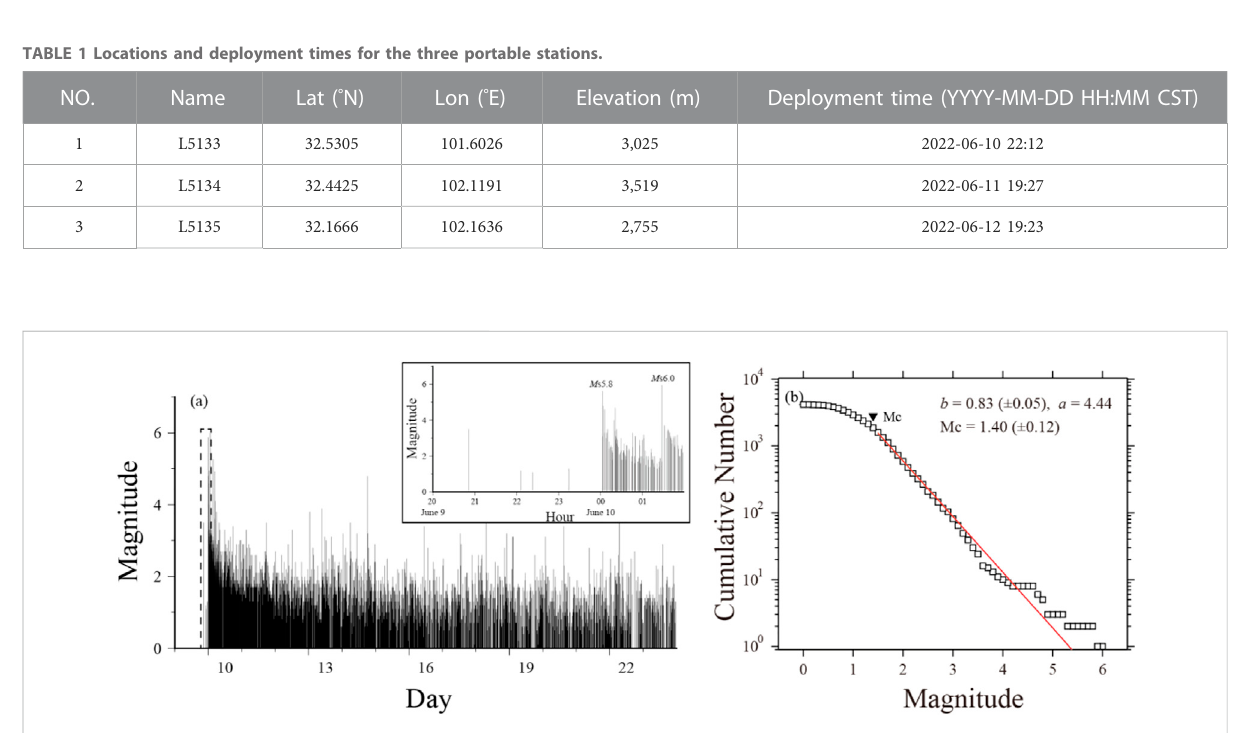
FIGURE 2 (A) M – t diagram of the Maerkang earthquake sequence during June 9 – 23, 2022. The dashed box highlights the early stage of the sequence, with its M – t diagram enlarged in the upper-right corner. (B) Frequency – magnitude distribution of the 2022 M s6.0 Maerkang earthquake sequence. Each square indicates the cumulative earthquake frequency at a given magnitude, and the red line is the best- fi t line to the G – R relationship (Gutenberg and Richter,